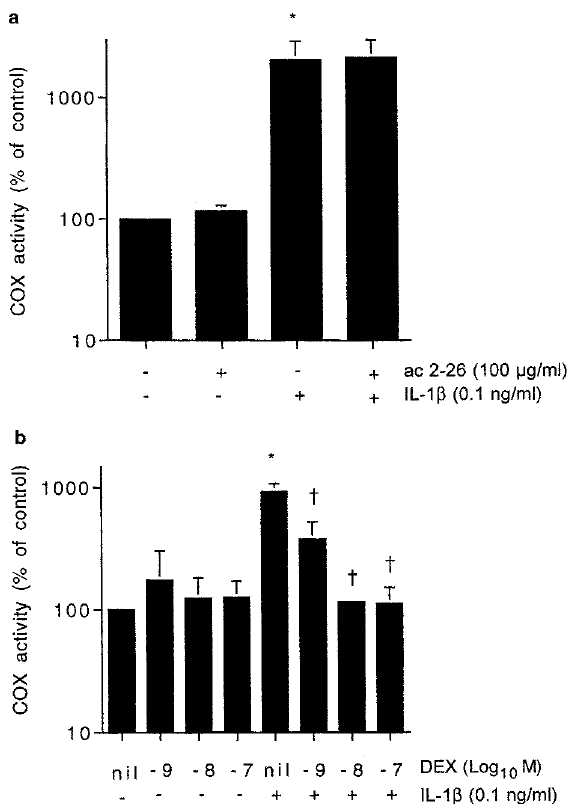
FIG. 5. COX activity in human FLS. FLS were treated with IL- 1 b (0.1ng/ml), and/or (a) annexin I ac 2–26 (100 m g/ml), (b) DEX (10 -9 –10 -7 M) for 8h and COX activity measured as described. COX activity is expressed as a percentage relative to untreated FLS. Values are the mean ± SEM of 4 experi- ments. * p < 0.01 versus untreated FLS, p < 0.05 versus IL- 1 b -treated FLS.